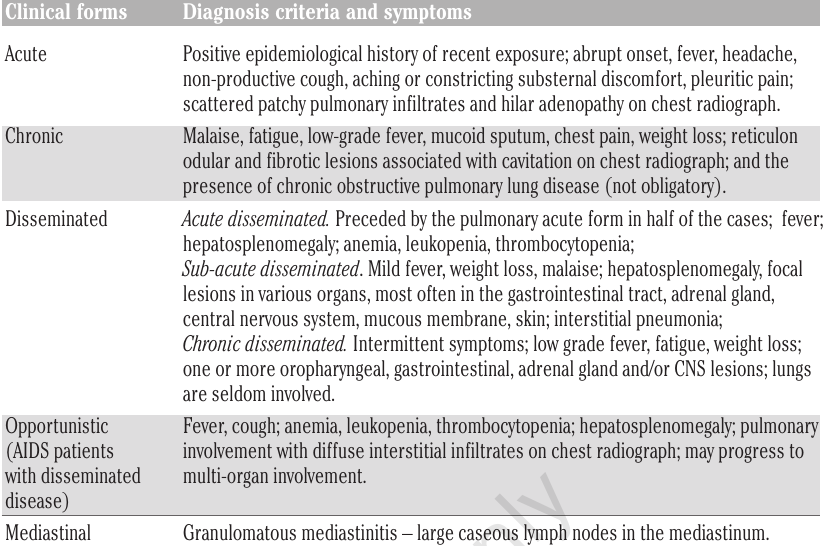
presence of chronic obstructive pulmonary lung disease (not